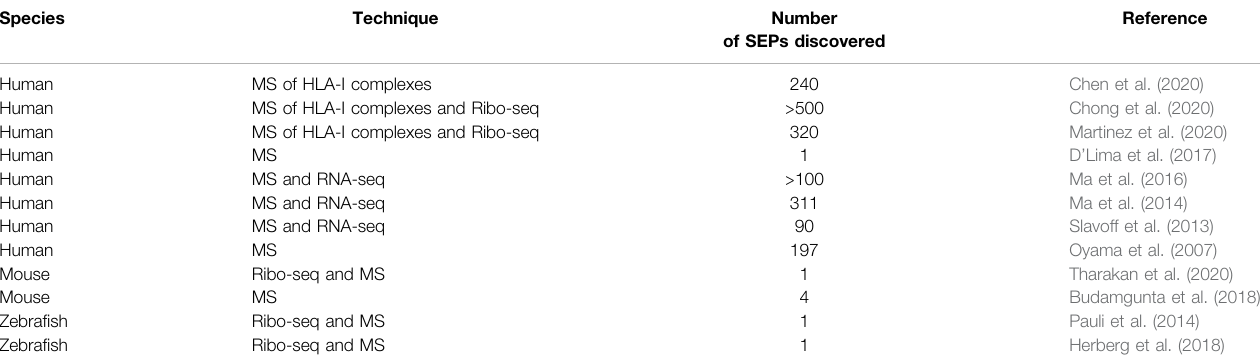
TABLE 2 | Studies detecting SEPs through transcriptomic and/or mass spectrometry techniques.